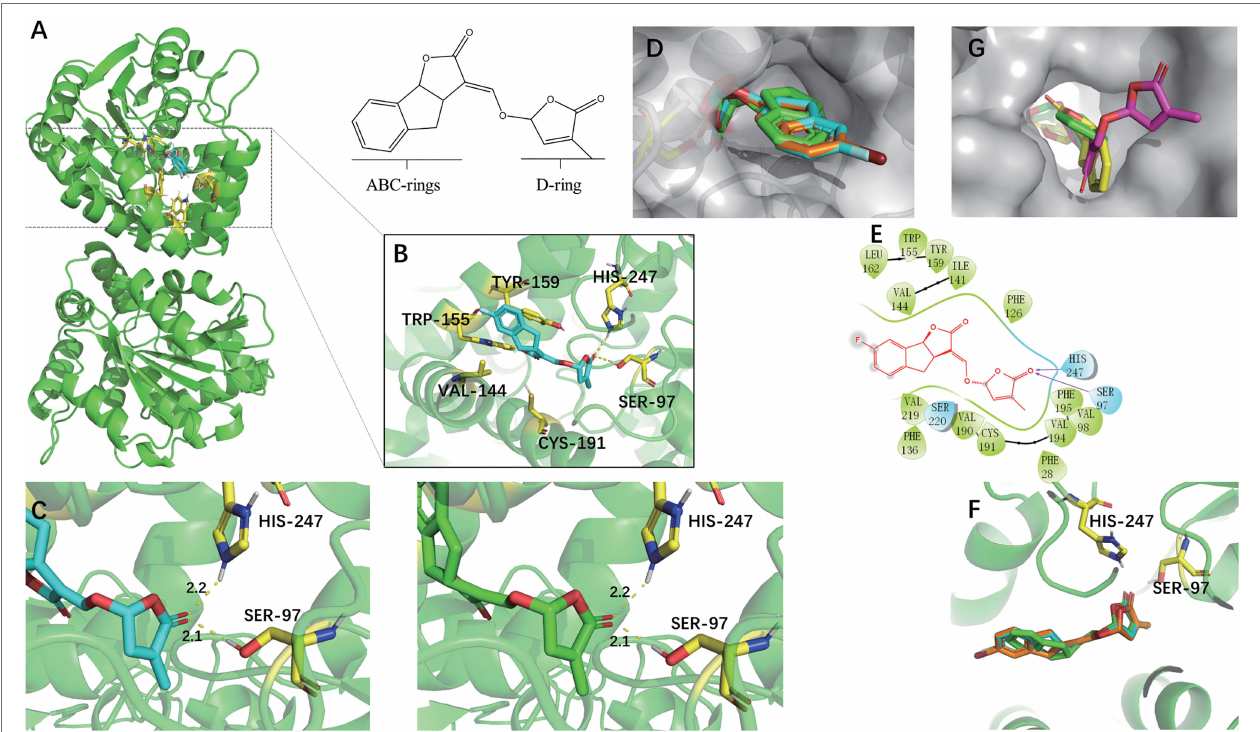
FIGURE 5 | Docking modes of ( − )-epi-GR24 and the halogenated (+)-GR24 analogs with OsD14. (A) Pocket location of OsD14 when 7FGR24 combined on it. (B) Spatial position and interaction force between 7FGR24 and important amino acid residues in the active pocket. (C) The distance of the polar connection between the 7FGR24/(+)-GR24 and Ser 97 and His 247. (D) The halogenated (+)-GR24 analogs in the active pocket (the yellow sticks in the pocket are SER97). (E) 2D view of 7FGR24 in the catalytic site of OsD14. (F) Comparison of binding postures of 7FGR24, 7BrGR24, and (+)-GR24. (G) Two ways of connecting ( − )-epi- GR24 to active pocket. The ( − )-epi-GR24 is shown as yellow and purple sticks, 7BrGR24 as orange sticks, 7FGR24 as blue sticks, and the original ligand of OsD14 – (+)-GR24 as green